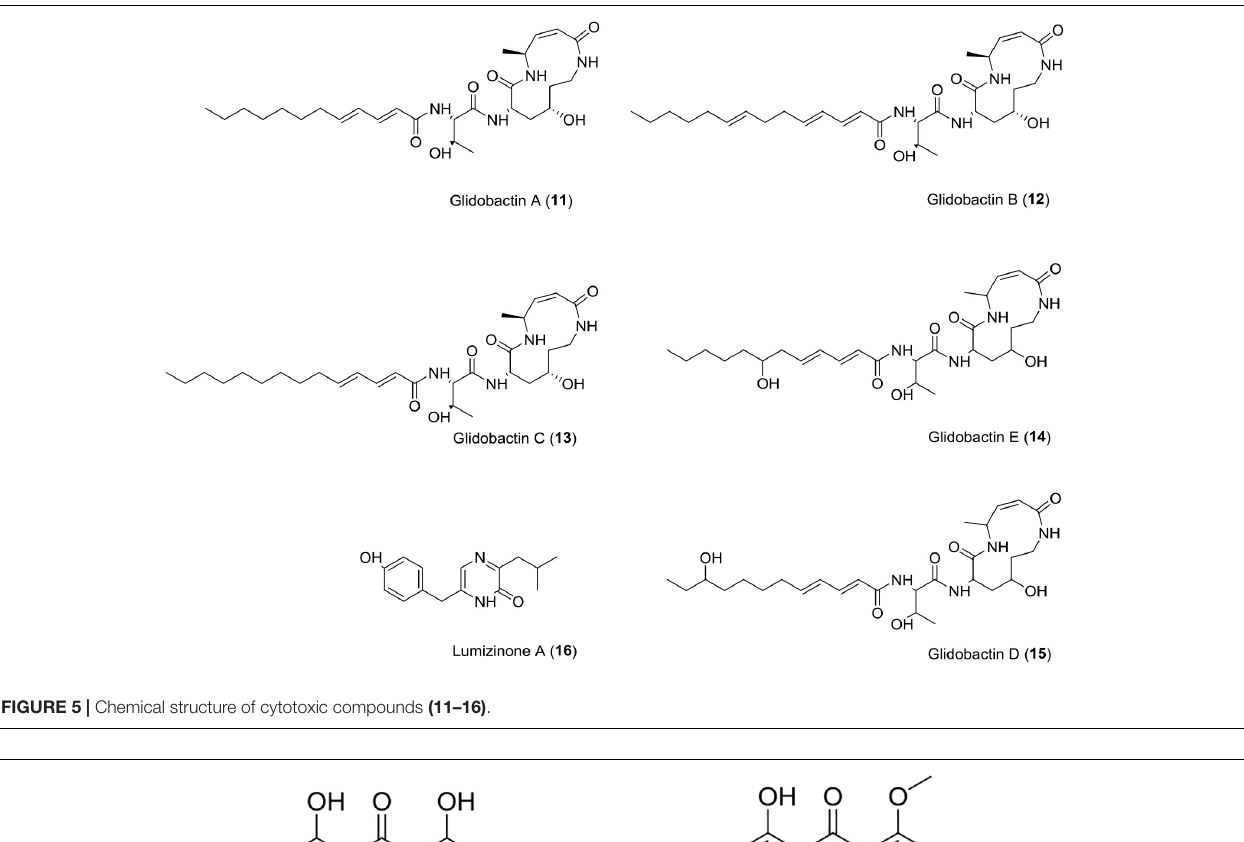
FIGURE 5 | Chemical structure of cytotoxic compounds (11–16) .